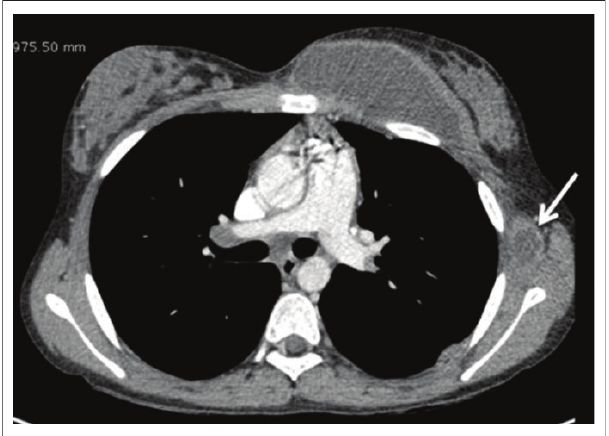
FIGURE 6: A 14-year-old female presenting with a left breast swelling. Axial post-contrast computed tomography image shows a large chest wall abscess involving the left pectoralis muscle with involvement of the costal cartilage and 5th rib. A similar but smaller collection was seen in the left subscapularis muscle (white